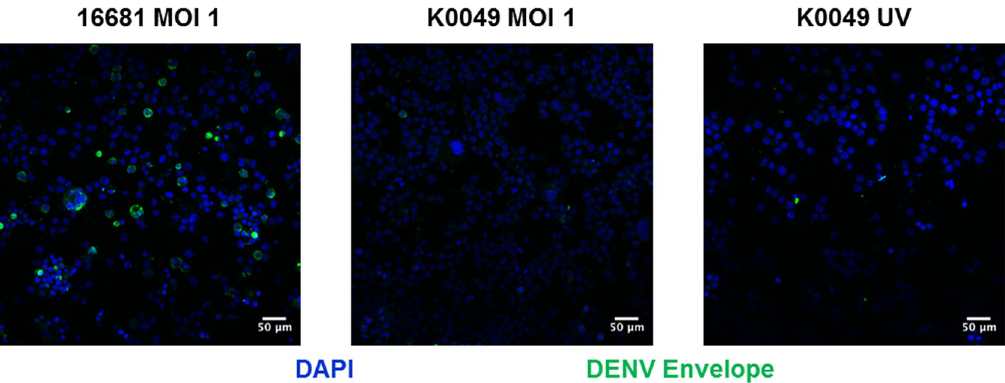
Fig 2. Dengue virus envelope protein is visualized in infected UT-7 cells. Representative immunofluorescence images of UT-7 cells infected with 16681 MOI 1, K0049 MOI 1, or UV-inactivated K0049 at day one post infection. Blue represents nuclei stained with DAPI. Green represents DENV envelope protein stained with the 4G2 monoclonal antibody. Scale bars are 50 μ M. Images were obtained using a Nikon A1SR microscope using NIS elements software.